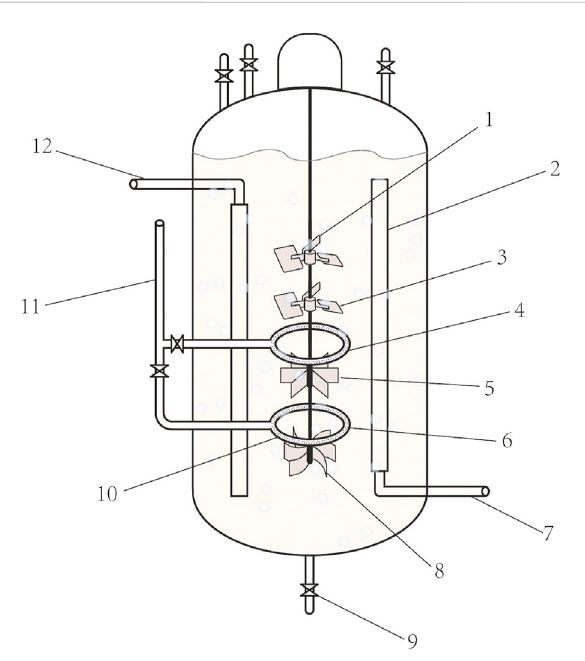
FIGURE 2 Oxygen-enhanced bioreactors. 1. Six inclined blade stirrers.